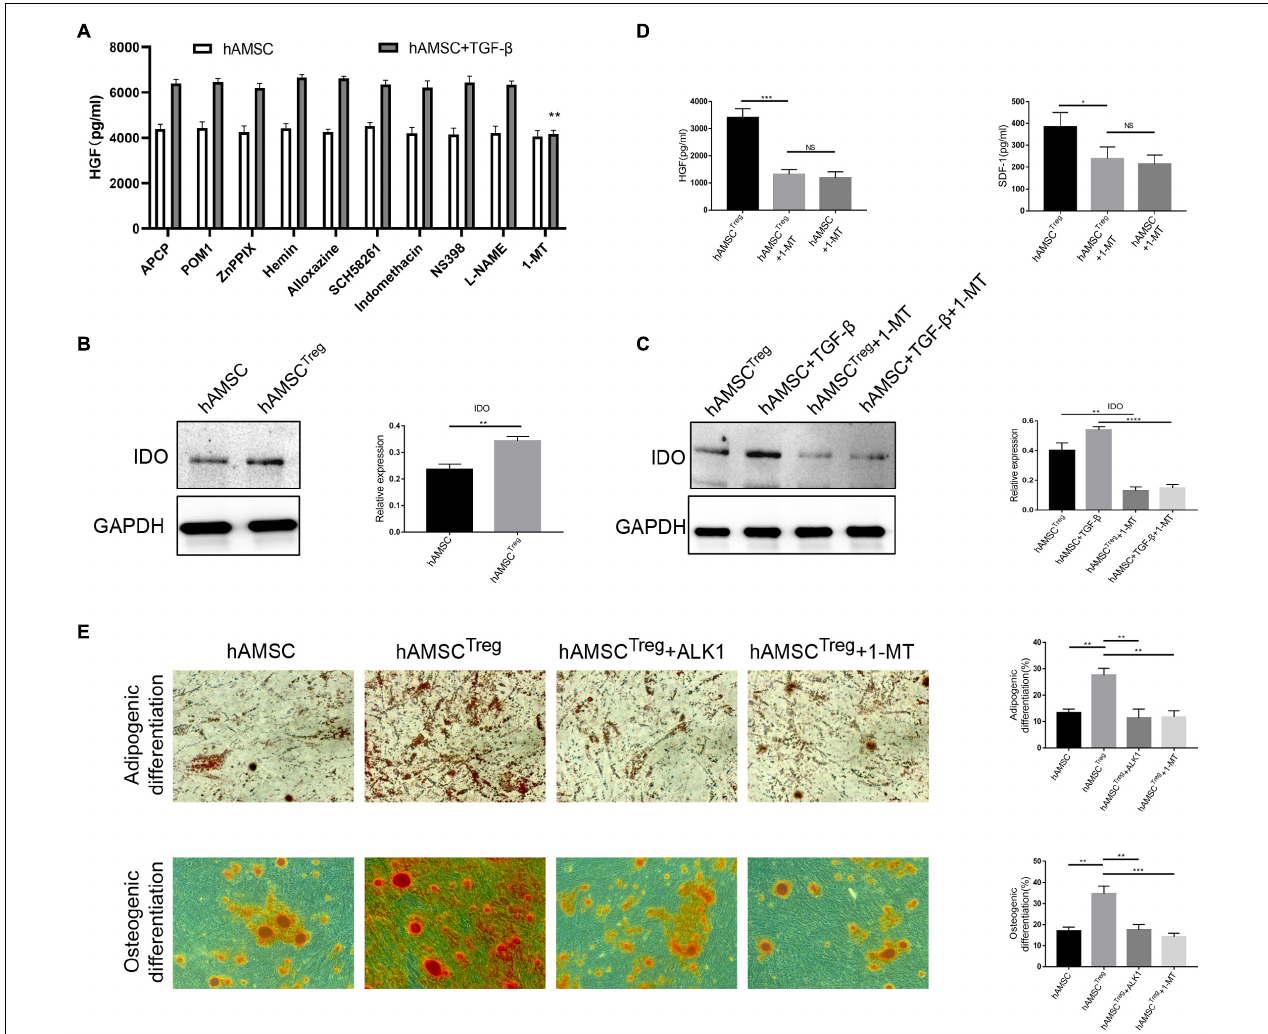
FIGURE 5 | Multiple signal neutralizers were added to the culture system and 1-MT was proved to be effective. (A) Level of HGF in hAMSC’s supernatant after adding multiple signal neutralizers. APCP: CD73 inhibitor; POM1: CD39 inhibitor; ZnPPIX: HO-1 inhibitor; Hemin: HO-1 inducer; ALLoxazine: adenosine receptor inhibitor; SCH58261: adenosine A2A receptor inhibitor; Indomethacin: COX inhibitor; NS398: COX-2 inhibitor; L-NAME: NOS inhibitor; 1-MT: IDO inhibitor. (B) IDO expression of PBS treated hAMSC and hAMSC Treg − S by western blot and the relative expression calculated by IDO versus GAPDH through Image J software. (C) IDO expression of hAMSC Treg − S , TGF- β , hAMSC Treg − S with 1-MT, and TGF- β with 1-MT by western blot and the relative expression calculated by IDO versus GAPDH through Image J software. (D) Level of HGF and SDF-1 in hAMSC, hAMSC Treg − S , and hAMSC Treg − S with 1-MT. (E) Adipogenic and osteogenic differentiation of hAMSC, hAMSC Treg − S , hAMSC Treg − S with ALK1, hAMSC Treg − S with 1-MT. The result is representative of three independent experiments. Data were mean ± SD of three independent experiments. * p < 0.05, ** p < 0.01, *** p <